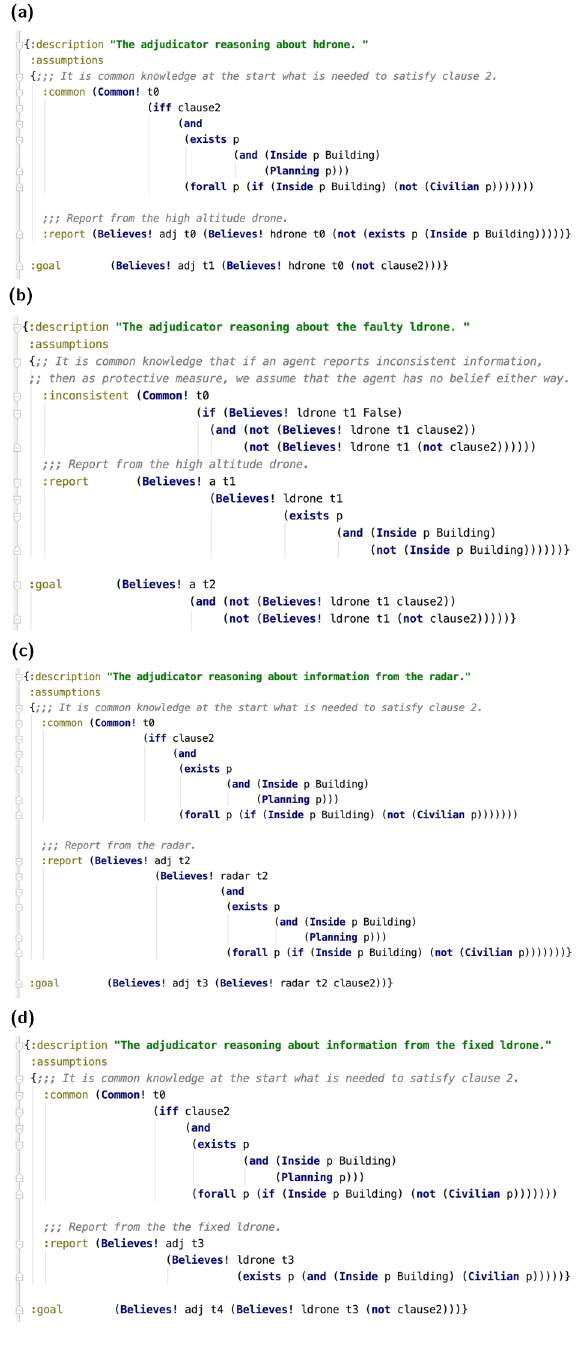
Figure A1: Inputs to ShadowProver to model the scenario.